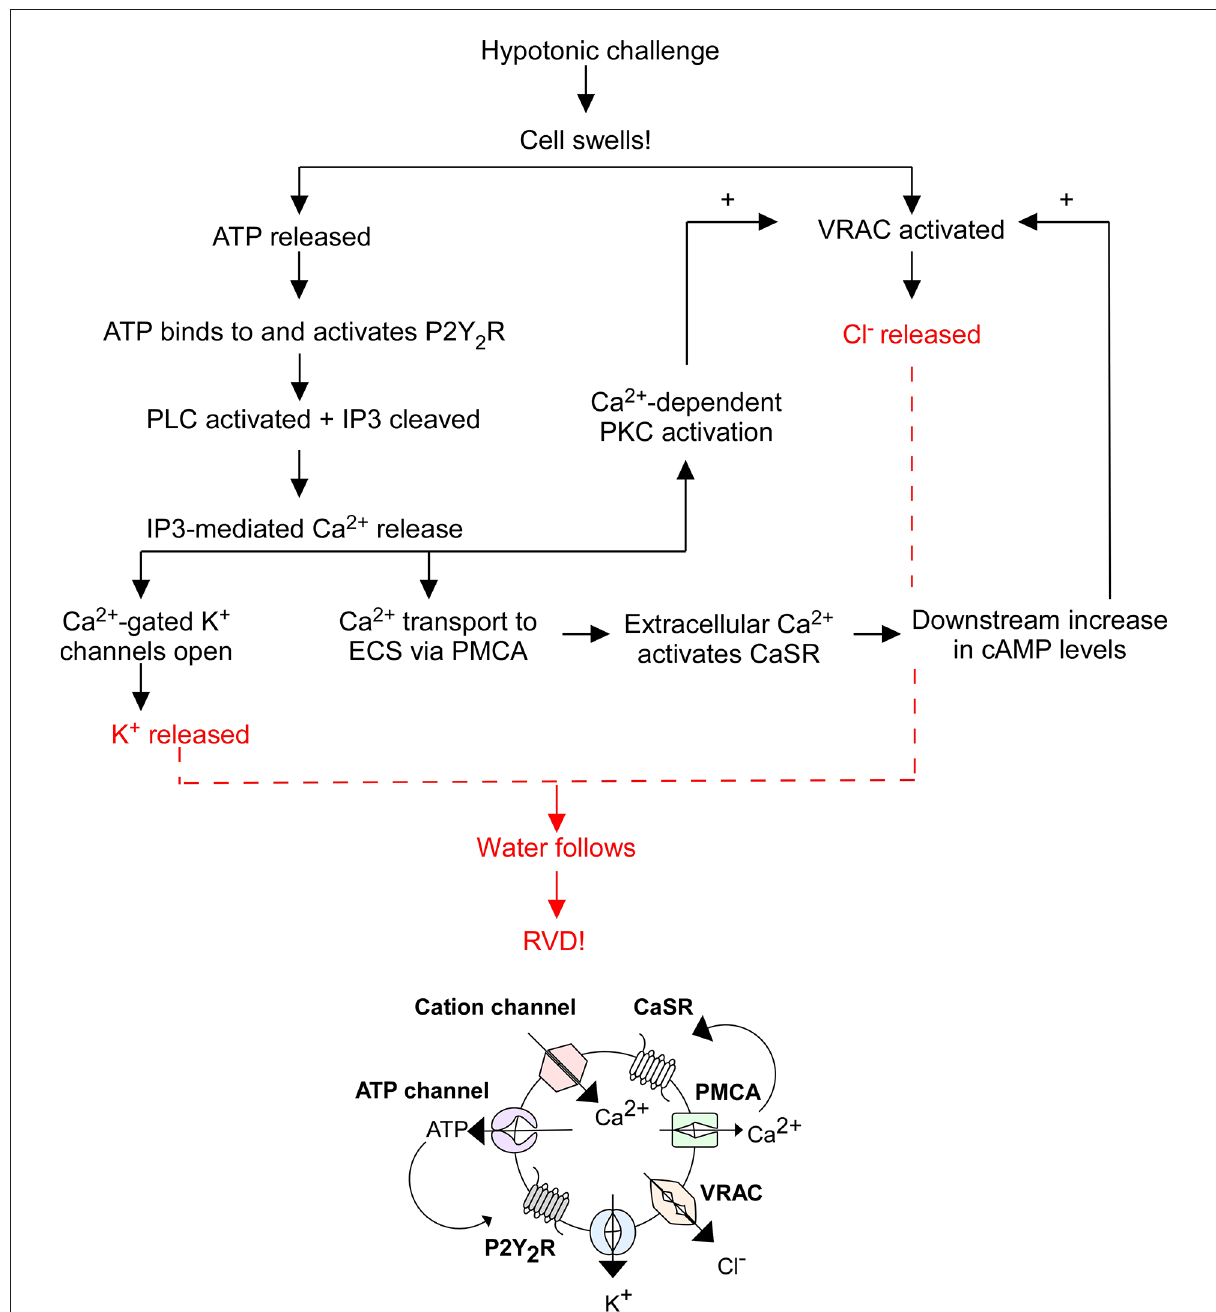
FIGURE1 Overview of regulatory volume decrease (RVD). The flowchart above outlines the general mechanism of RVD and is illustrated by the diagram belowit.ThisprocessincludesmultiplecellularplayersincludingP2Y 2 receptors(P2Y 2 R),Ca 2+ -sensingreceptors(CaSR),plasmamembraneCa 2+ ATPase (PMCA), cation channels, K + channels, VRAC, phospholipase C (PLC), inositol triphosphate (IP 3 ), and cyclic adenosine monophosphate (cAMP), the end result of which is an efflux of K + and Cl − to facilitate the efflux of water and subsequent cell